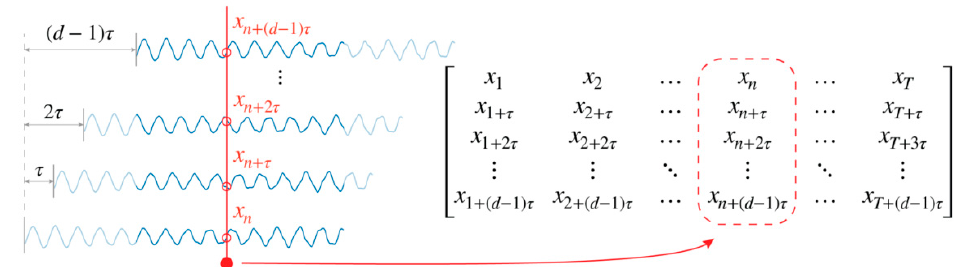
Figure 3. Conversion from sequence to attractor matrix. A single signal is delayed by τ , thus creating a new signal. The d signals are gathered and put into a matrix to form the attractor matrix.